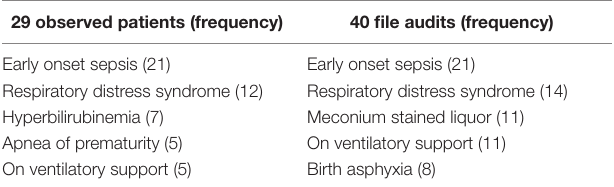
TaBle 2 | common clinical diagnoses.